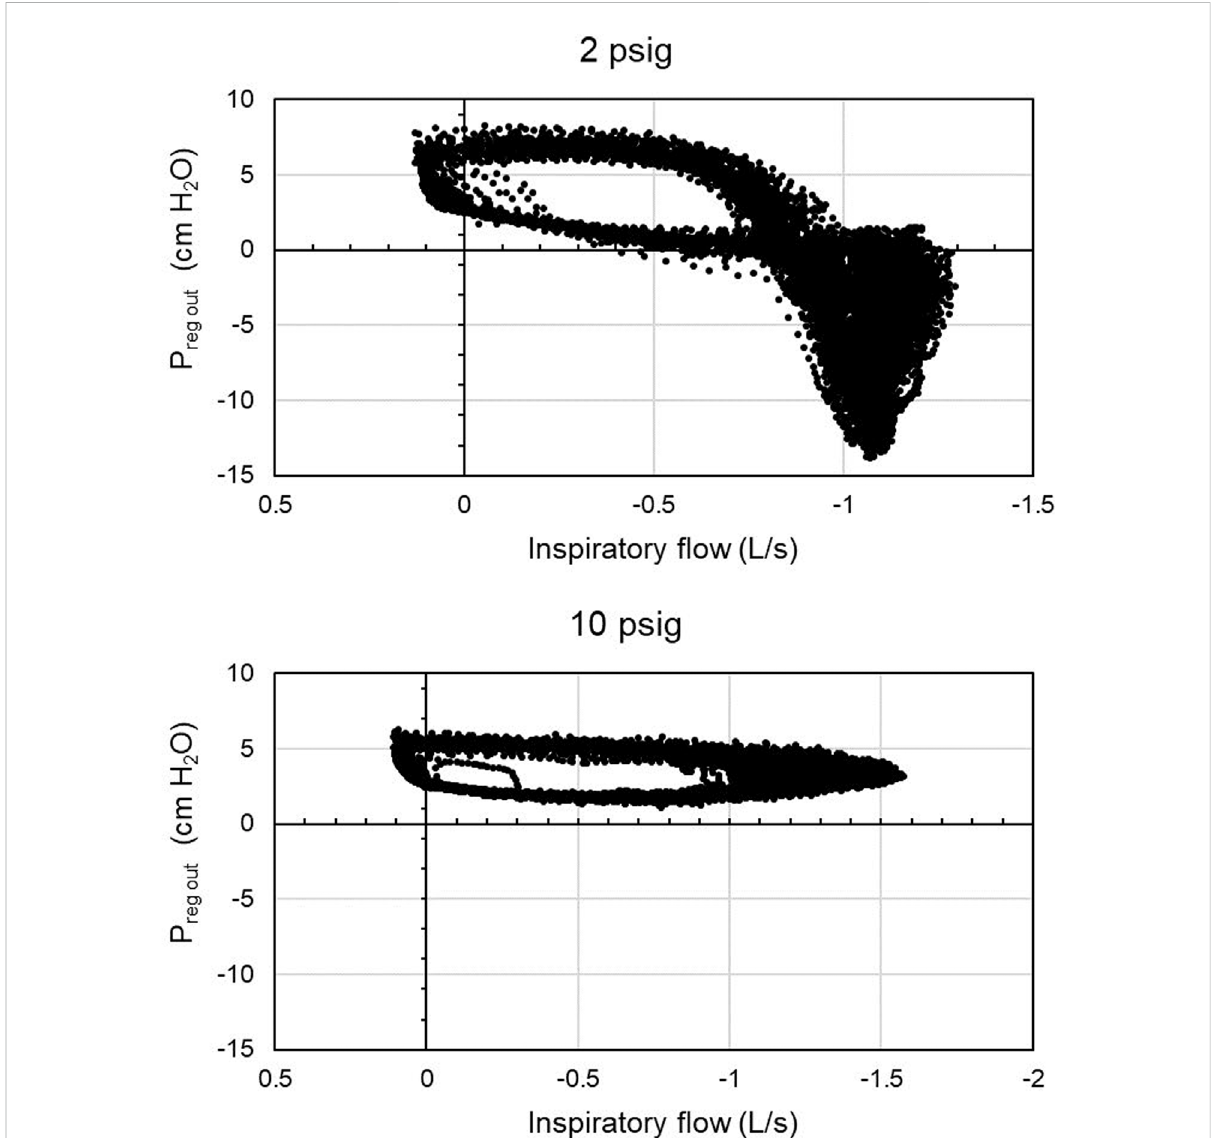
FIGURE 3 Regulator outlet pressure relative to room pressure showing fl ow limitation from the regulator. Data are from participant 3 with a nominal regulator inlet pressure of 10 and 2 psig. Regulator inlet pressure in reality varied from breath to breath depending on breathing characteristics. Inspiratory fl ow is given in negative values to correspond to negative mask pressures, but is plotted here with magnitude increasing to the right. At 2psigsupplypressure,theCRU-103couldnotsupport fl owsgreaterthanroughly1.25 L/s,resultinginnegativepressuresattheregulatoroutlet relative to the room as the participant drew air out of the breathing hose faster than the regulator could deliver it.